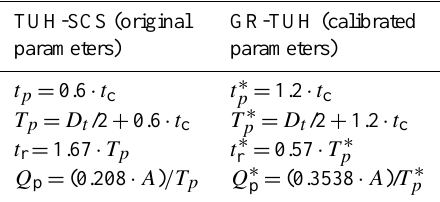
Table 2. Parameters used for defining the TUH-SCS and the GR-